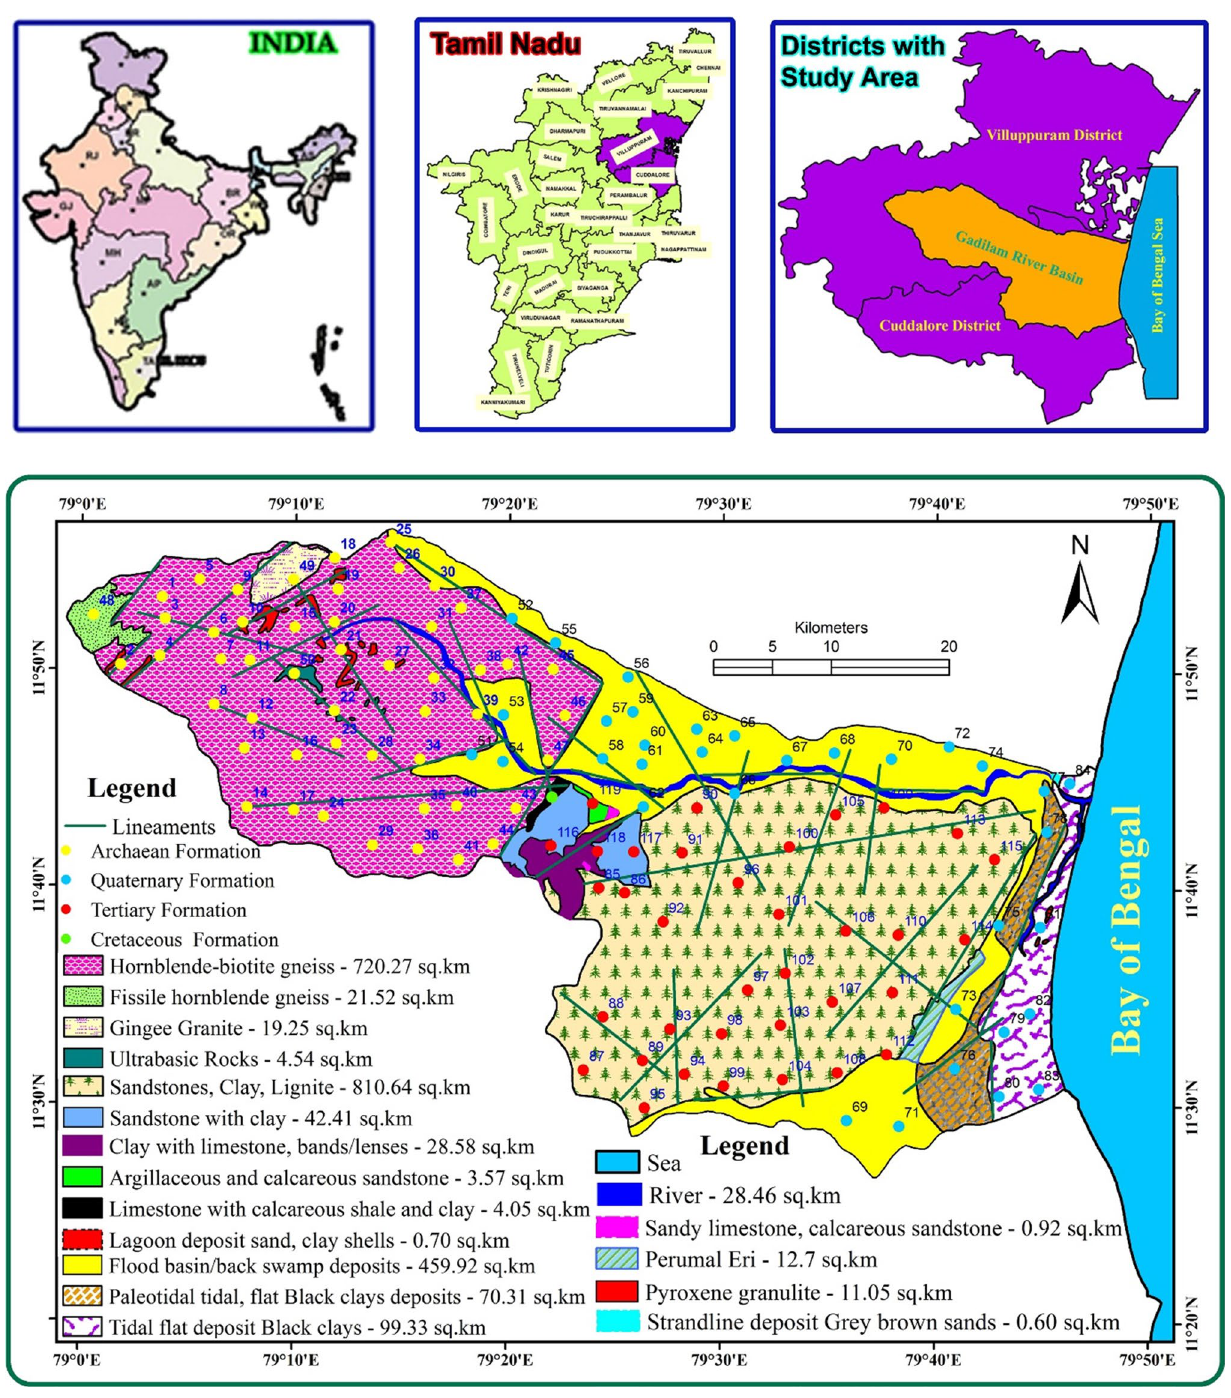
Fig. 1 Key map of present the systemic random approach is implemented with pre- determined locations (Rahman et al. 2012; Selvam et al. 2018). Figure 1 indicates the distribution of 50 samples from the Archaean formation collected (Hornblende-bio- tite gneiss, Fissile hornblende gneiss, Gingee Granite and